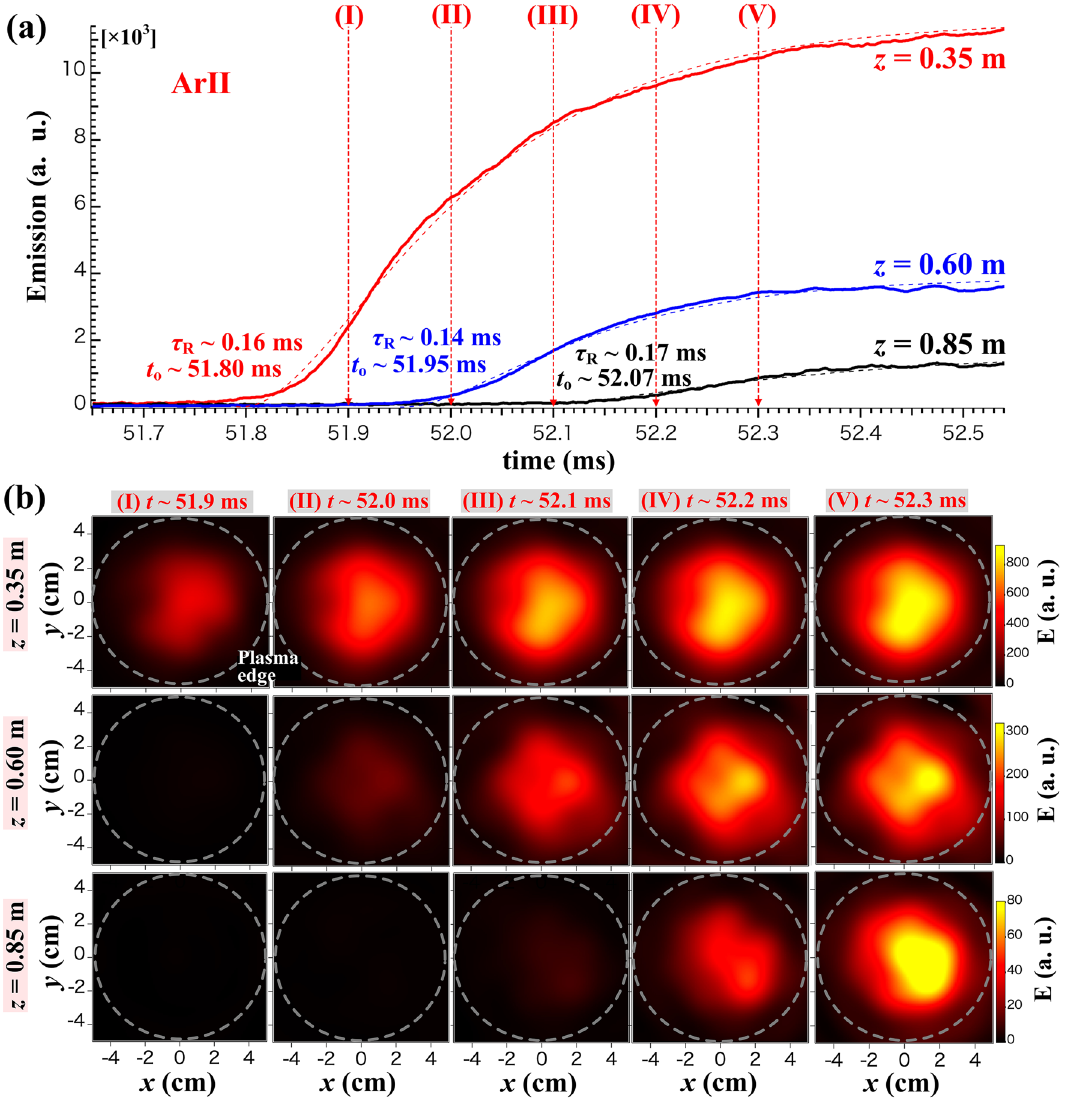
Figure 3. ( a ) Temporal evolution of the total emission and ( b ) two-dimensional images of emission at the three axial positions during the plasma production phase, z = 0.35, 0.60, and 0.85 m. The images are obtained using the FBF fitted to MLEM profile. The dashed circles indicate the plasma